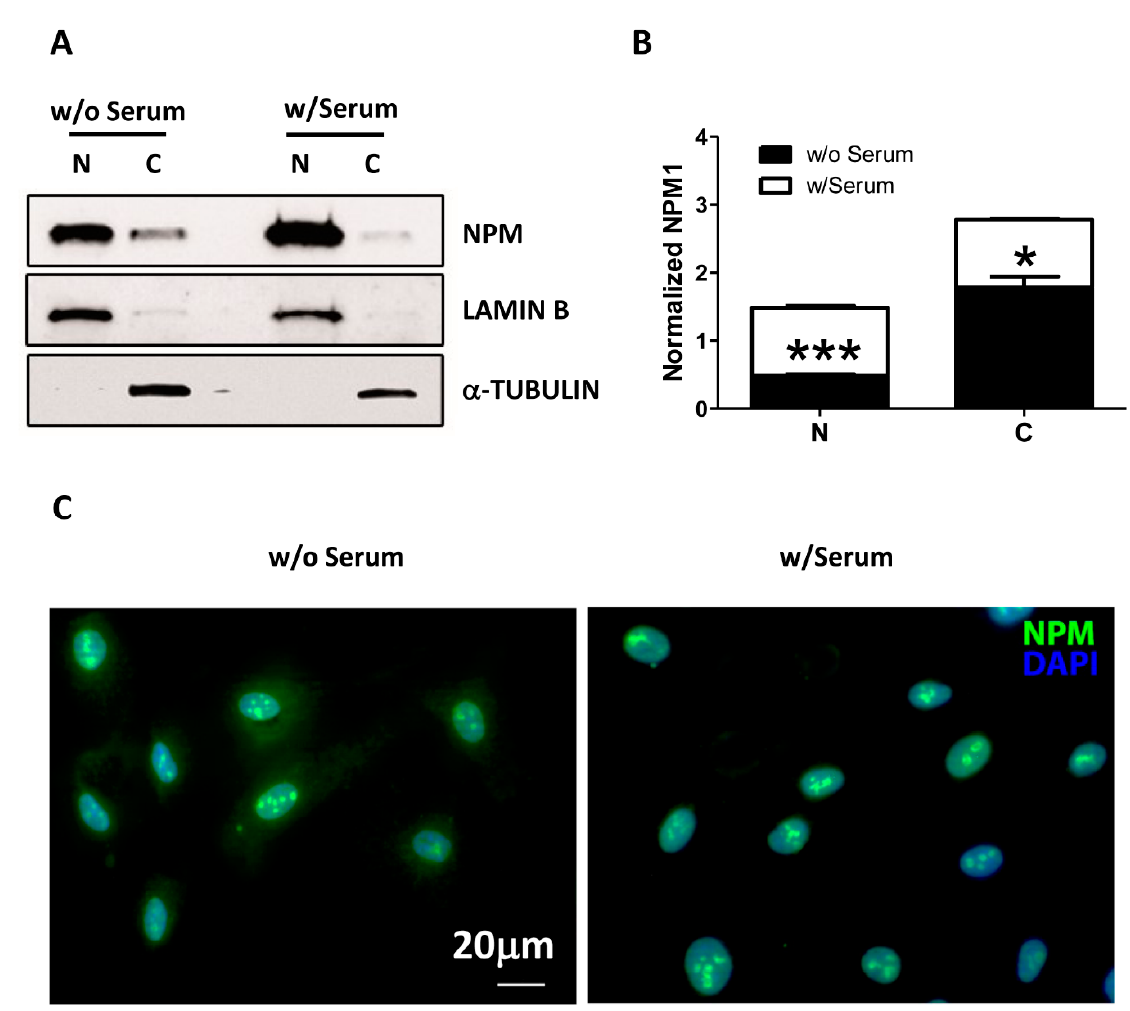
Figure 1. ( A–C ) . Western Blotting analysis of cytoplasm and nuclear fraction of nucleophosmin (NPM) in human vein endothelial cells (HUVEC) after serum starvation. ( A ) Representative blot displaying the shuttle of NPM. Lamin B and α -tubulin have been employed as nuclear and cytoplasmic protein, respectively. ( B ) The densitometry analysis shows that NPM translocates from nucleus to the cytoplasm after serum deprivation (w/o Serum) but not in the presence of serum (w/Serum). Data are the results of 3 independent experiments. * p < 0.05, *** p < 0.001. ( C ) Immunofluorescent staining of HUVEC confirming a delocalized NPM in the cytoplasm in the absence of serum (w/o Serum) but not in presence of serum (w/Serum). NPM and DAPI stain green and blue, respectively. Scale bar is displayed.